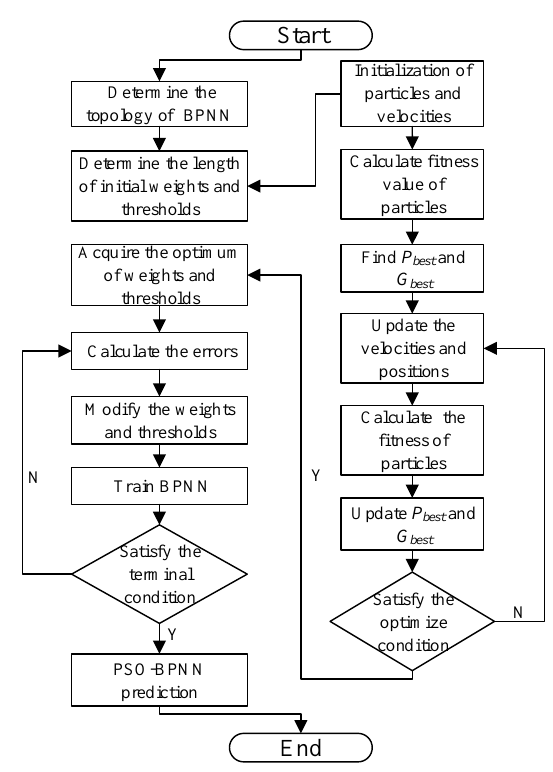
Figure 6. The optimization process of PSO-BPNN.